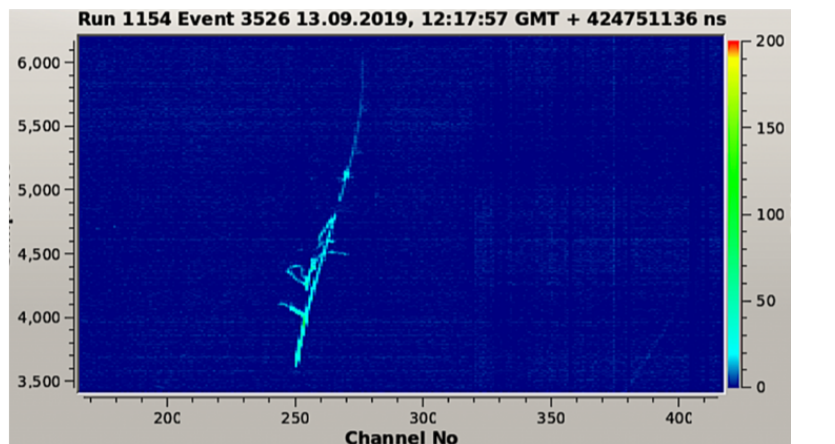
Figure 9. Cosmic ray data from the dual phase